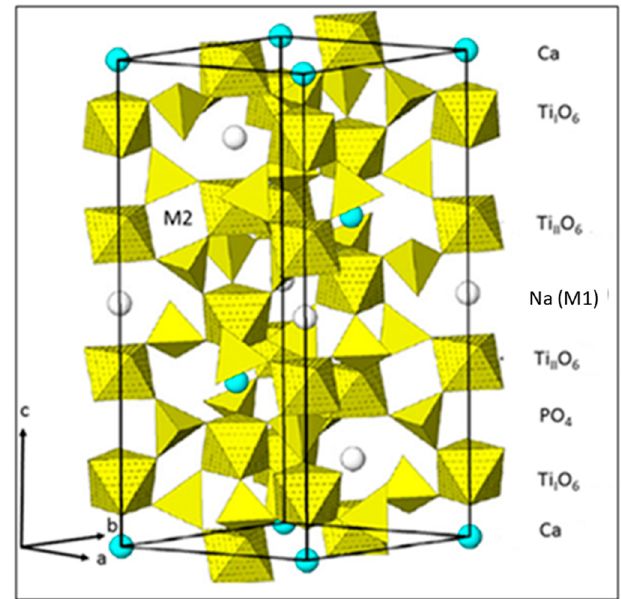
Figure 1. Unit cell of CaTi 4 (PO 4 ) 6 doped with Na ions located in M1 vacancies [12]. © With the permission of the Mineralogical Society of America.